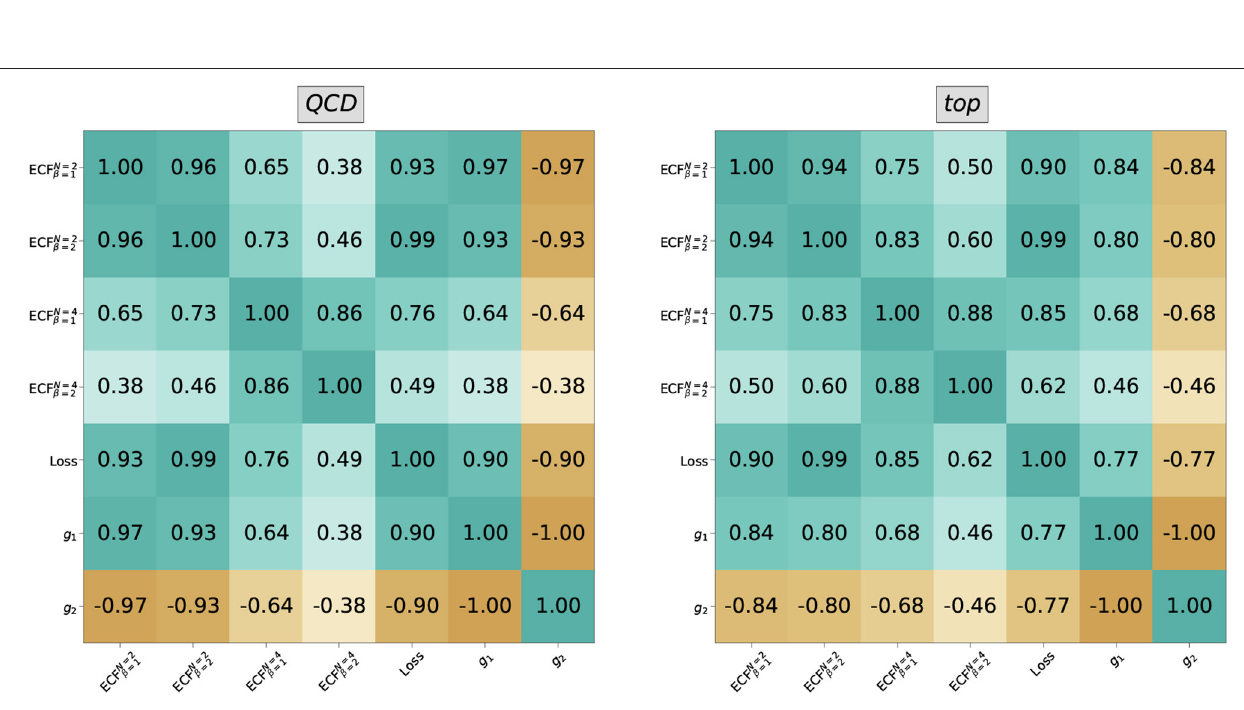
FIGURE 5 | The correlation of IRC safe loss (cf. Equation 8) and latent dimension (obtained with Equation 12) is shown with the Energy Correlation Functions (13). One can see a very high correlation of the ECFs with the variables obtained from the network, hinting at a close connection between